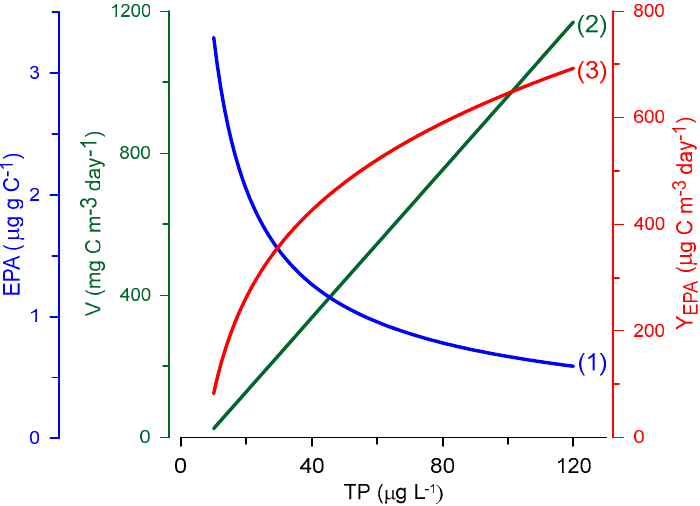
Figure 2. Dependence of the content of eicosapentaenoic acid in lake seston, EPA (1), rate of photosynthesis (primary production), V (2), and the yield of EPA, Y EPA (3), on the total phosphorus concentration in water, TP.